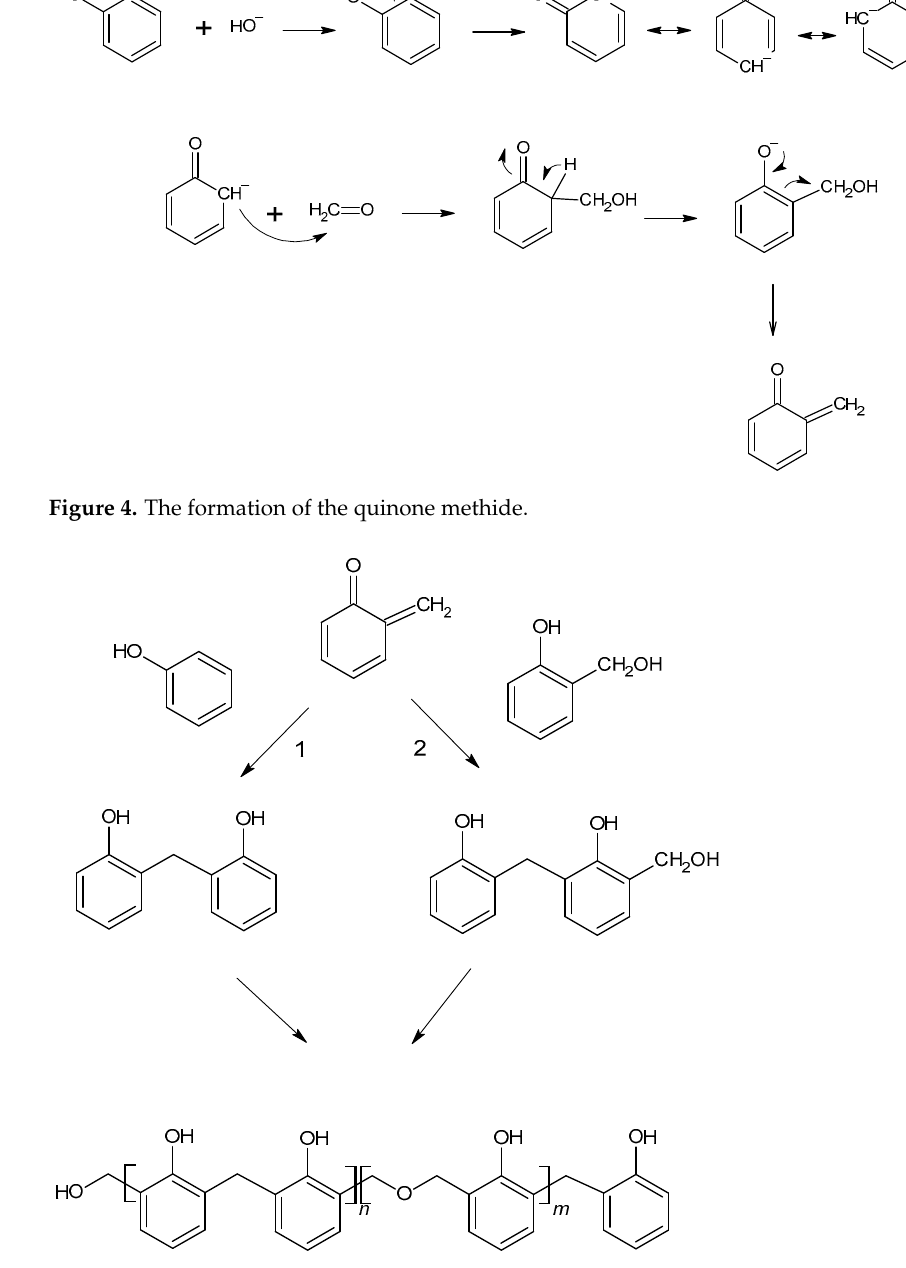
Figure 5. The formation of phenol formaldehyde resin.